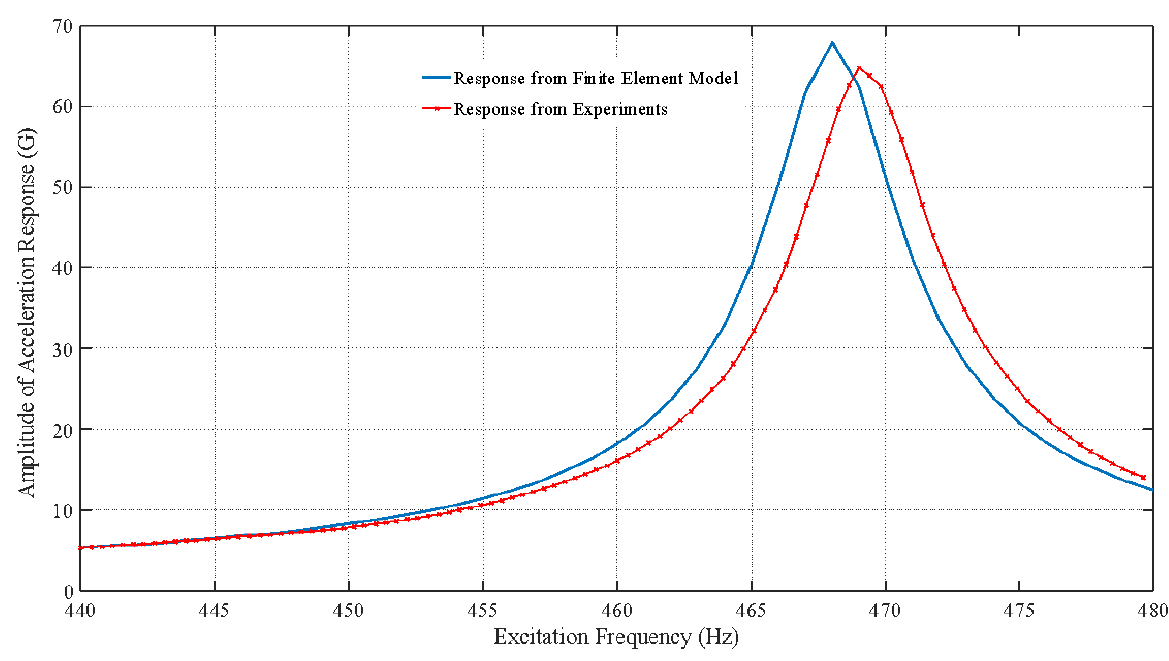
Figure 8. Frequency response function (FRF) of the test vehicle with a 1-mm board thickness.